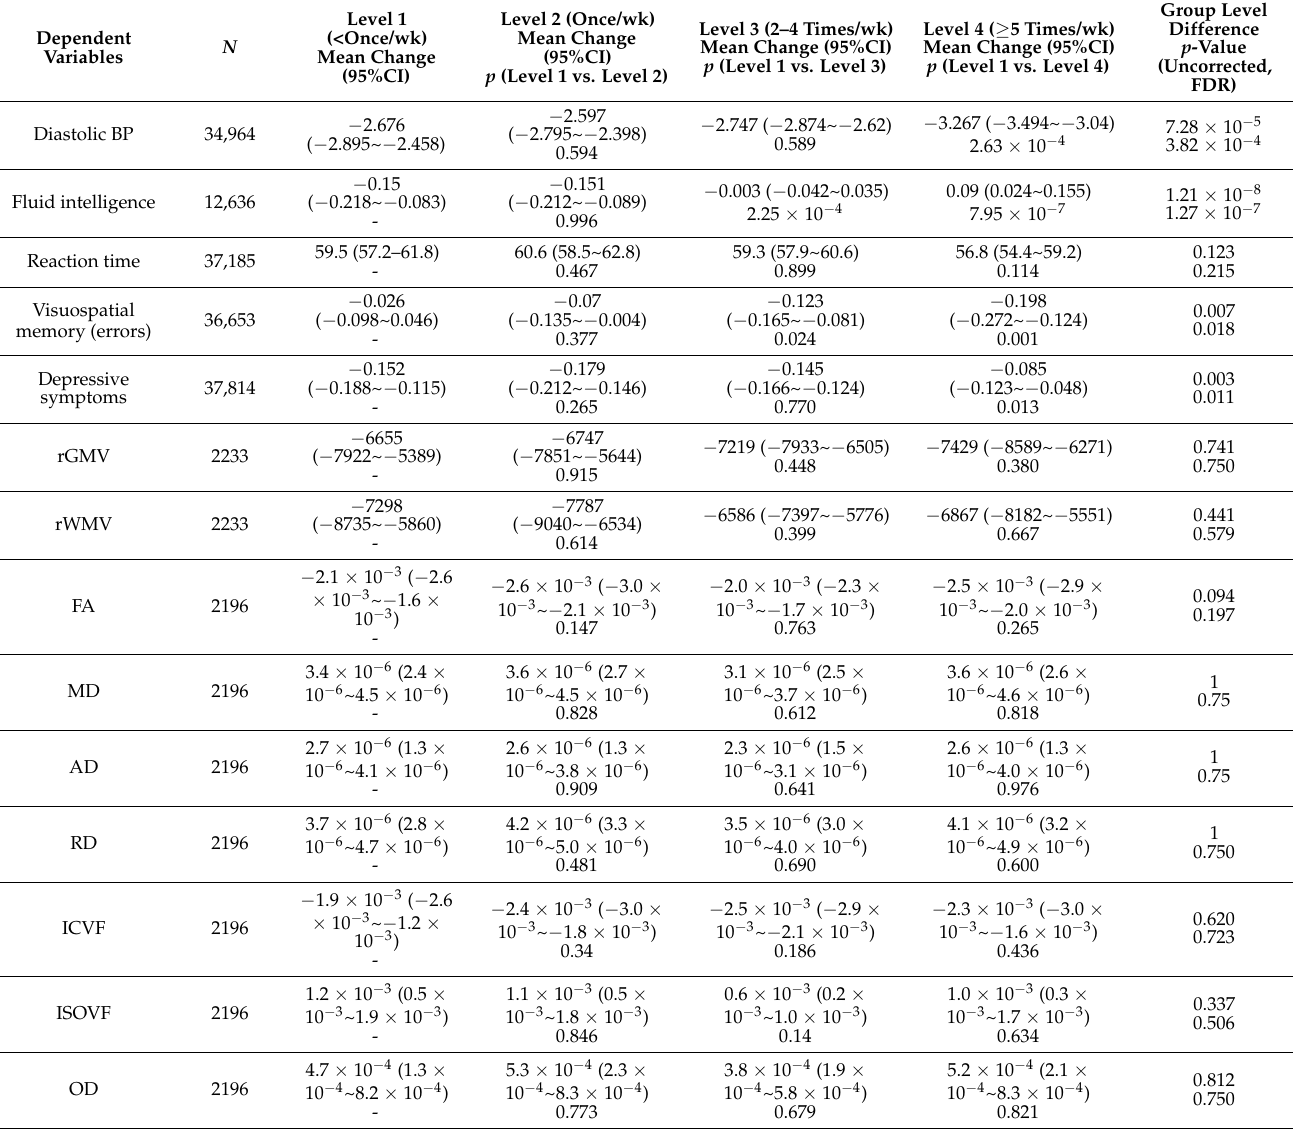
Table 3. Associations between baseline cheese intake and longitudinal changes in diastolic BP and psychological and imaging parameters revealed by multiple regression